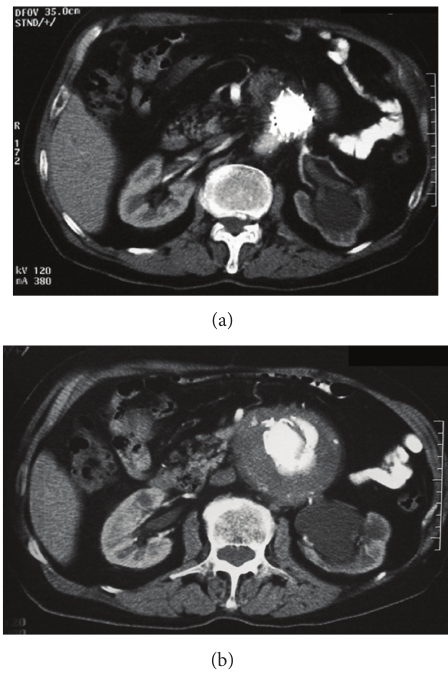
Figure 6: CT scanning one year after EVAR. (a) Migration of the endograft to the straight part of the neck. (b) Endoleak type I detected in the